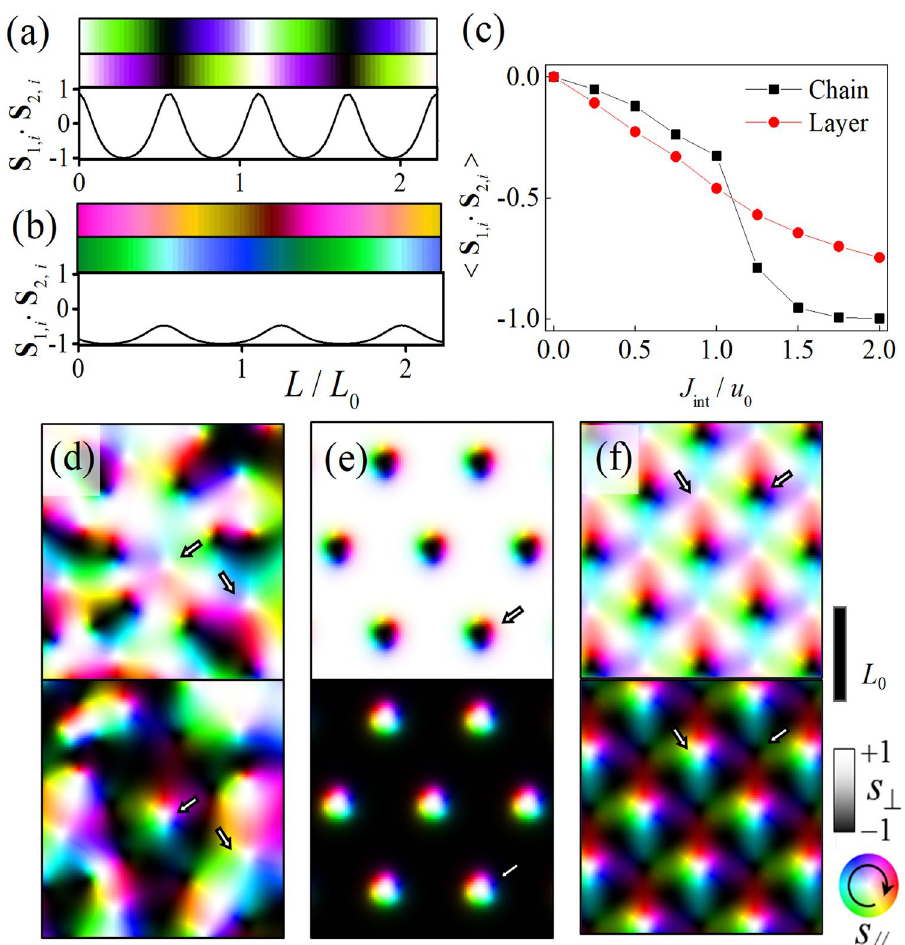
Figure 1. Magnetic structure of linear chains and S 1, i ∙ S 2, i in the case of ( a ) | J int | = u 0 and ( b ) | J int | = 1.25 u 0 . Top panel shows the spin configuration of layer 1, middle panel shows the spin configuration of layer 2, and the graph of bottom panel shows S 1, i ∙ S 2, i . ( c ) Spin correlation of the system vs. interlayer coupling strength. Red and black lines denote the spin correlation of layer and chain system. ( d – f ) Magnetic structures obtained under the same strength of interlayer coupling (| J int | = 2 u 0 ). The differences are from the different initial setups of skyrmion seeds. The top panel shows the spin configuration of layer 1, bottom panel shows the spin configuration of layer 2. Arrow are used to indicate the same positions in two layers. The scale bar is L 0 . The color wheel and gray scale show the spin